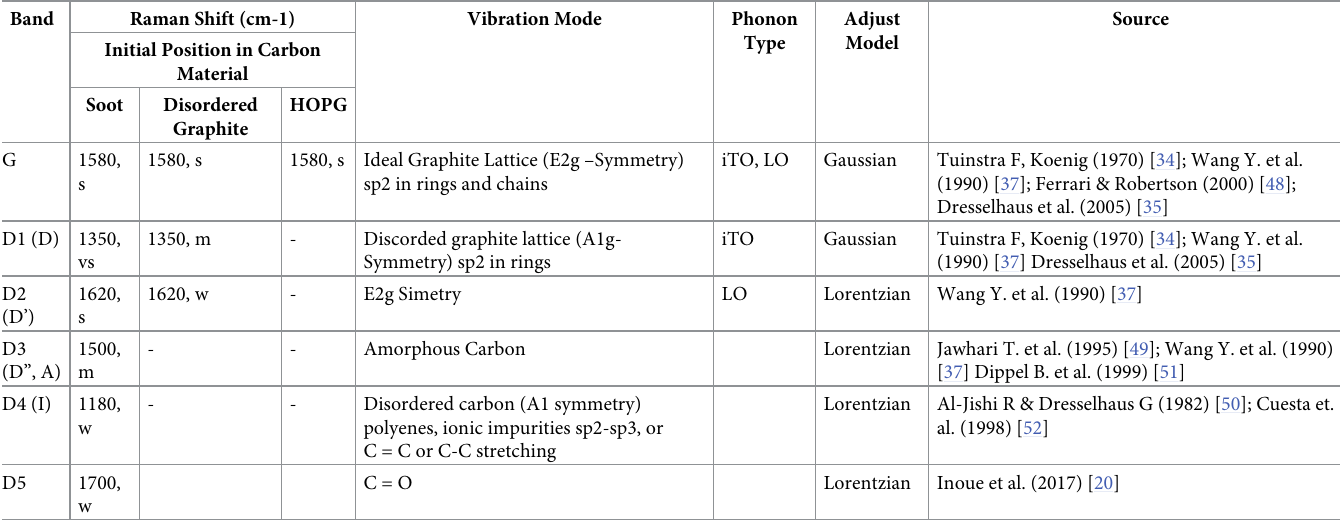
Table 2. General information on the bands used in this work.